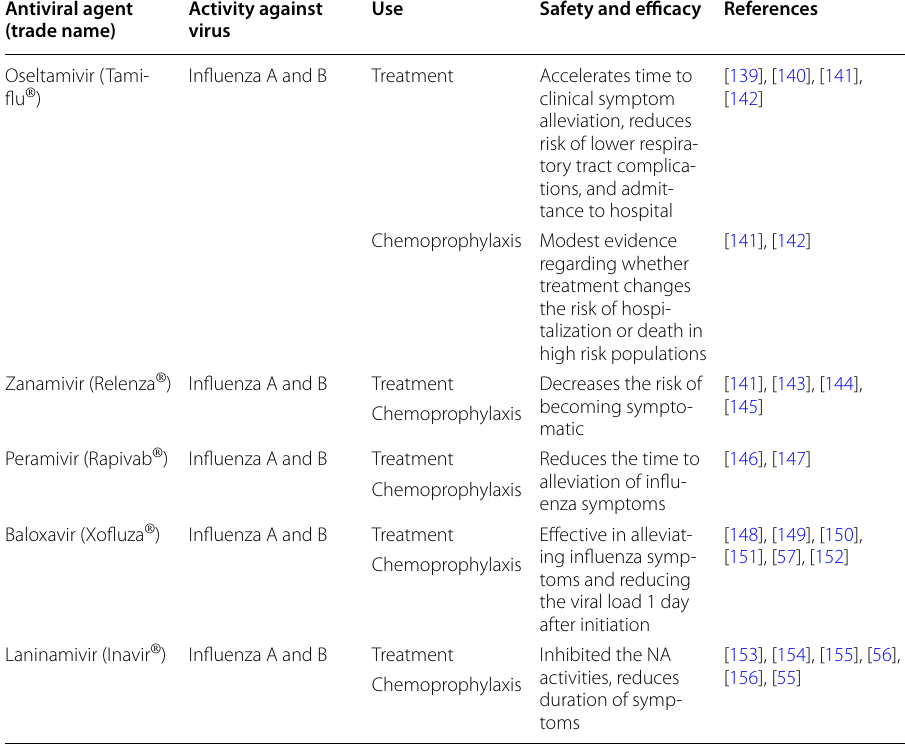
Table 2 Antiviral medications approved and recommended for treatment and chemoprophylaxis of